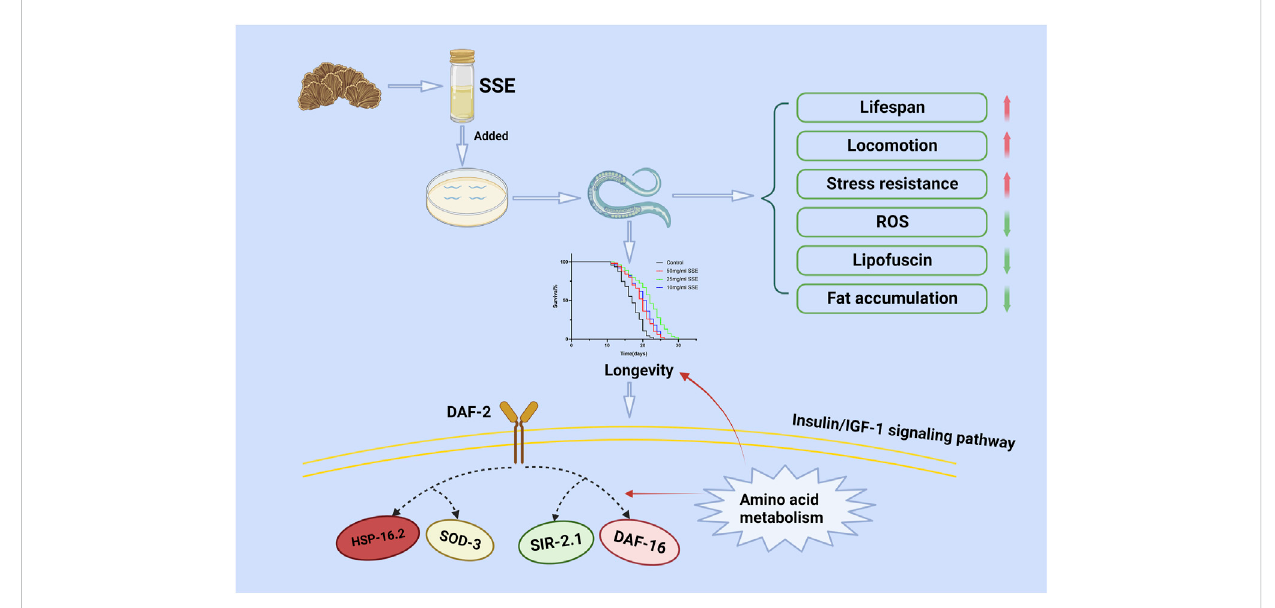
FIGURE 9 Possible molecular mechanism of the anti-ageing effect of SSE . Drawn using